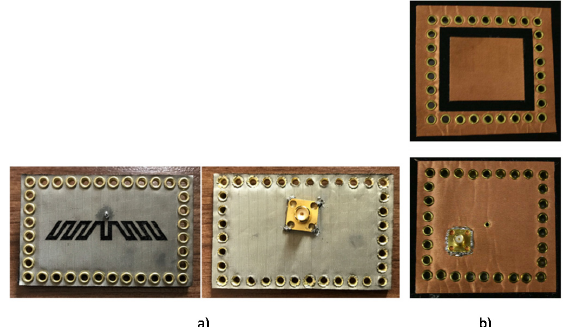
Figure 9. Antennas fabricated using the substrate integrated waveguide (SIW) method. ( a ) The prototype of the SIW antenna using conductive fabrics [122] and ( b ) prototype of the circularly polarized SIW antenna